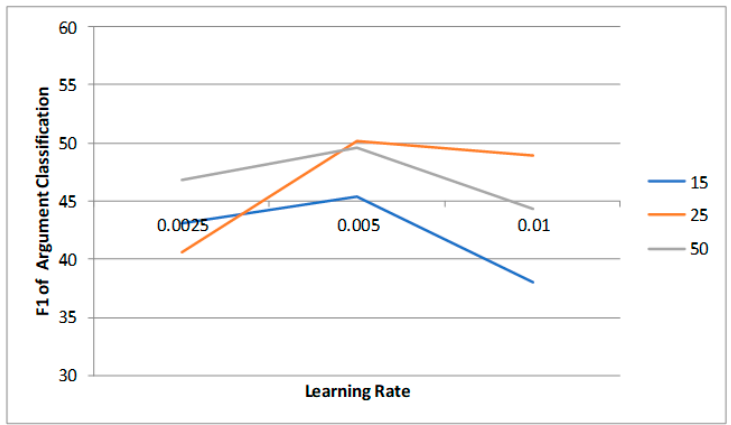
Figure 7. The influence of learning rate and batch size on argument classification. Table 1.